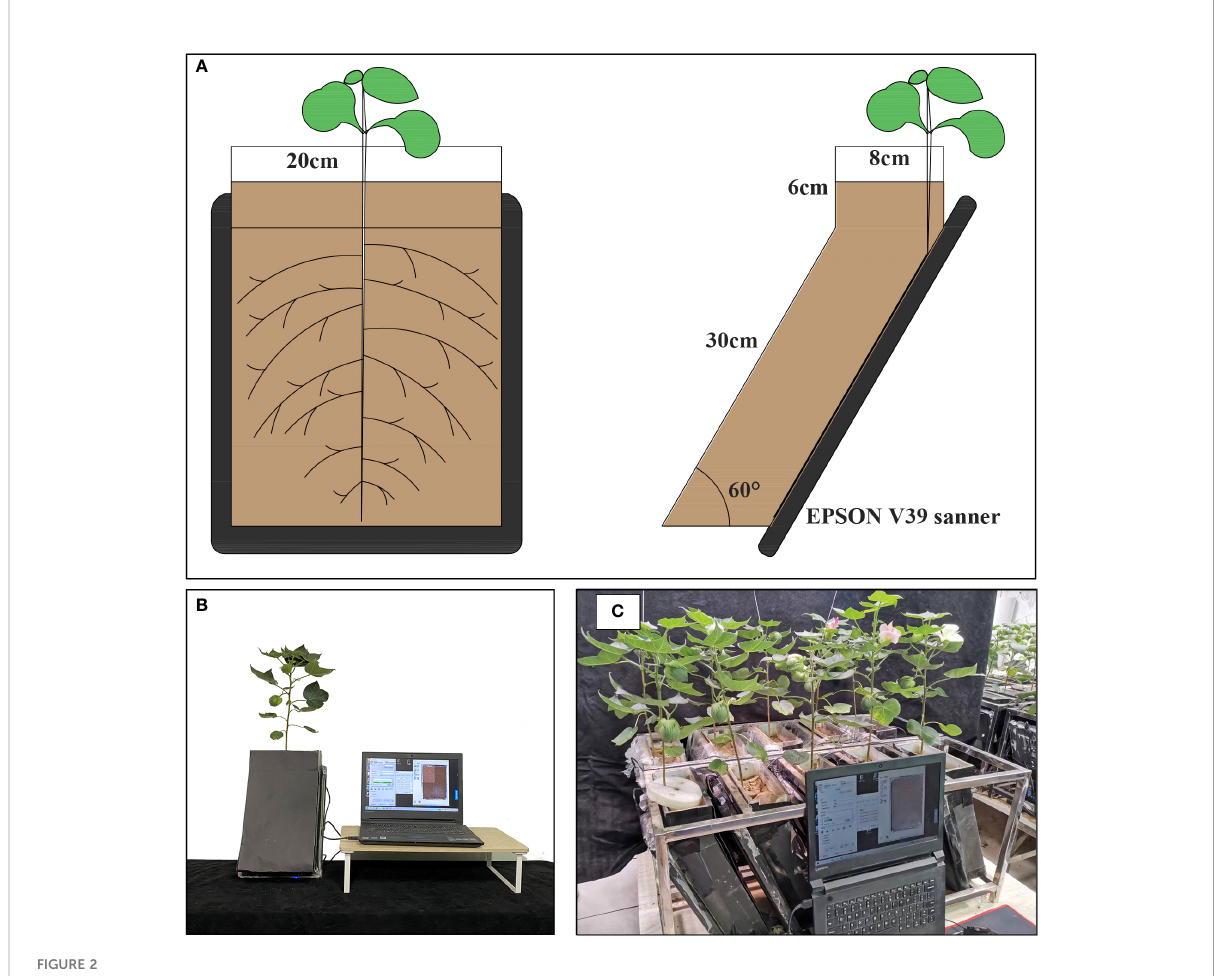
FIGURE 2 RhizoPot ’ s single cross-cuts (A) , single entity photos (B) , and batch work drawings (C) .